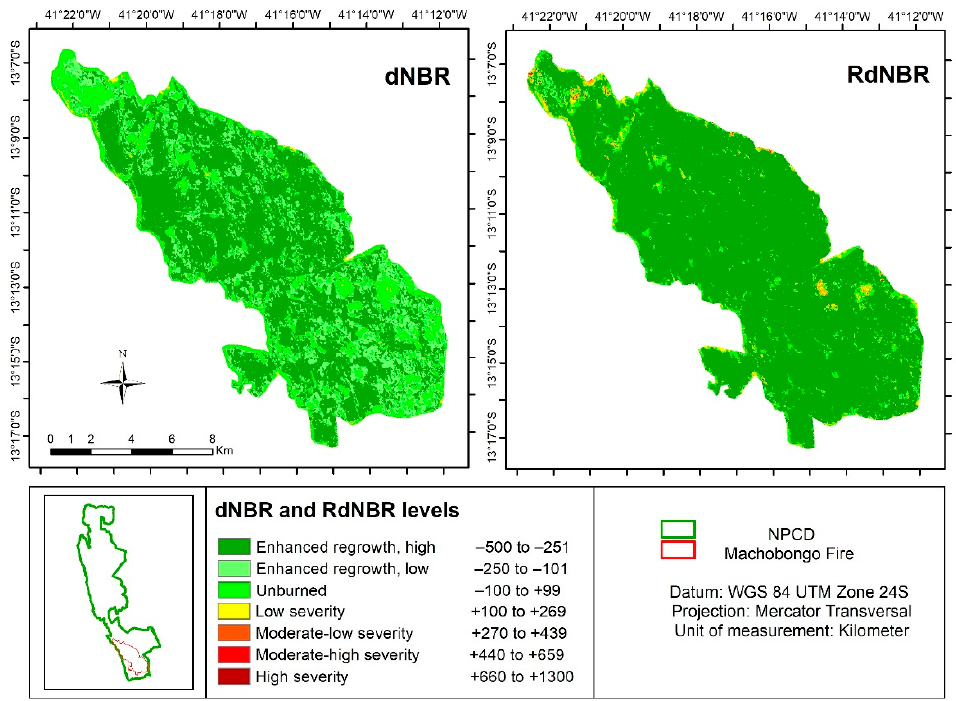
Figure 15. Regrowth following the fire identified by the dNBR and RdNBR indices relating to the Gerais do Machobongo fire (classification by Key and Benson [10]).